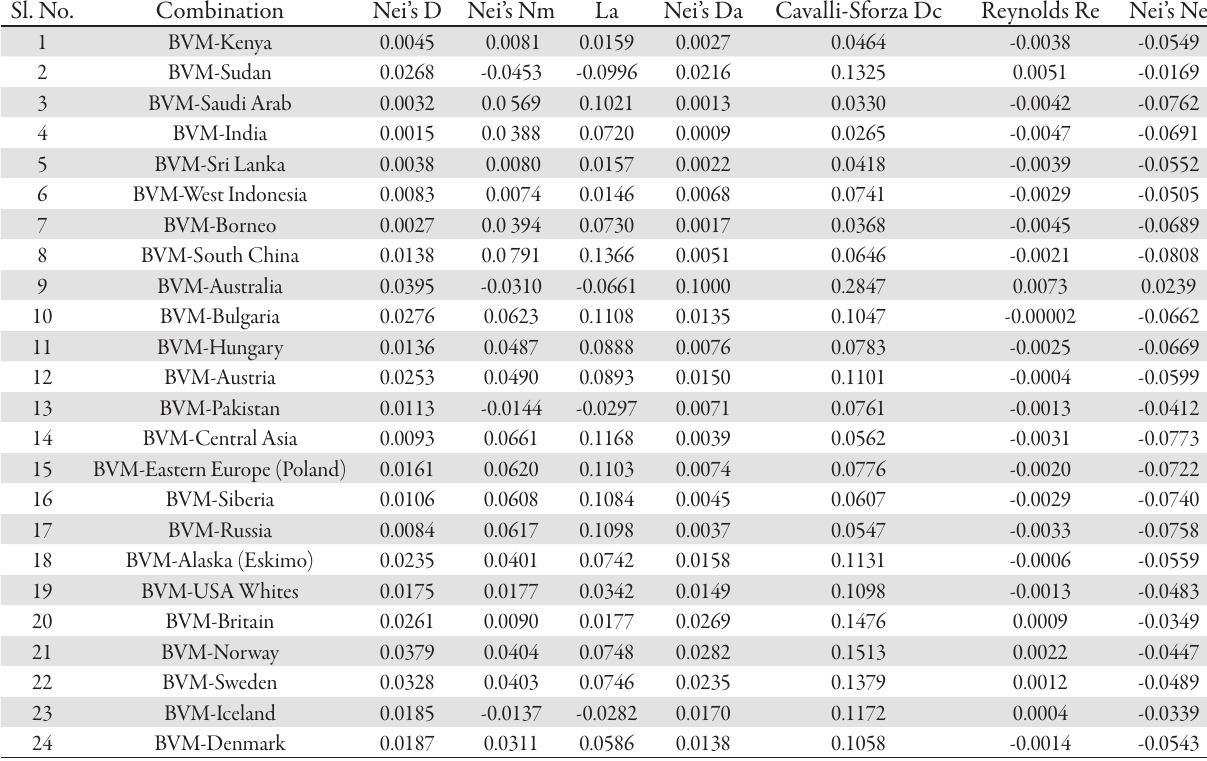
Tab. 2. Estimates of seven different genetic distance measures between BVM and other nations Sl.